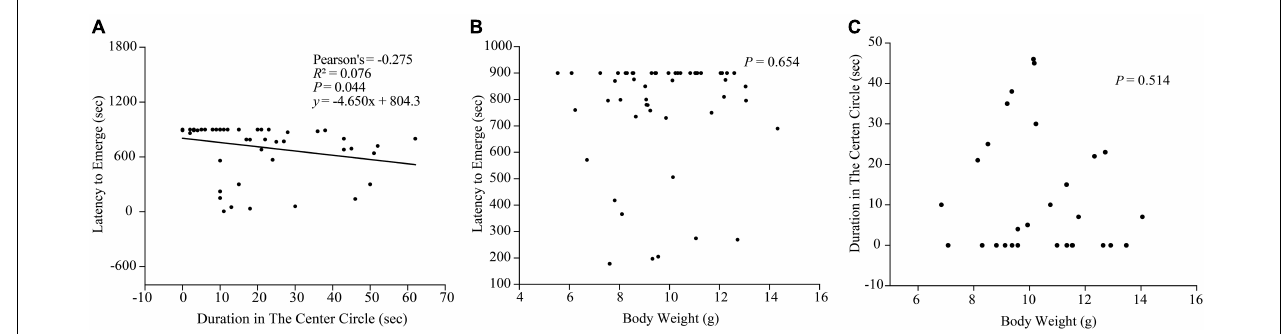
FIGURE 8 | (A) Correlation between the duration in center circle in the open-field test and the emerging latency in the box-emerging test. (B) Correlation between body weight and latency to emerge in the box-emerging test ( n = 53). (C) Correlation between body weight and duration in the center circle in the open-field test ( n =